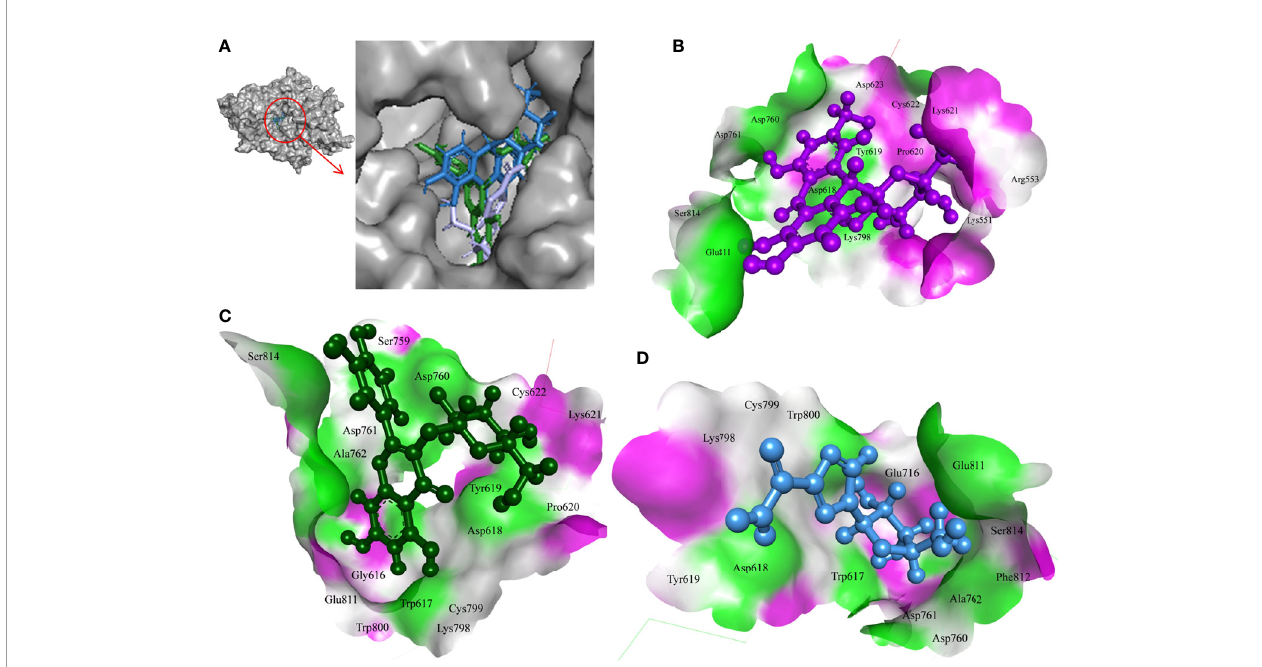
FIGURE 4 | Interaction of lead phytochemicals and standard inhibitor with RdRp protein of SARS-CoV-2. (A) Binding pose of ribinavir (Cyan), Isoquercetin (Violet), and 10-Hydroxyaloin A (Green). (B) Interaction of Spike-protein RBD domain with isoquercetin shown with the hydrogen bond surface of receptor. (C) Interaction of Spike-protein RBD domain with 10-Hydroxyaloin A shown with the hydrogen bond surface of receptor. (D) Interaction of Spike-protein RBD domain with ribinavir shown with the hydrogen bond surface of receptor.